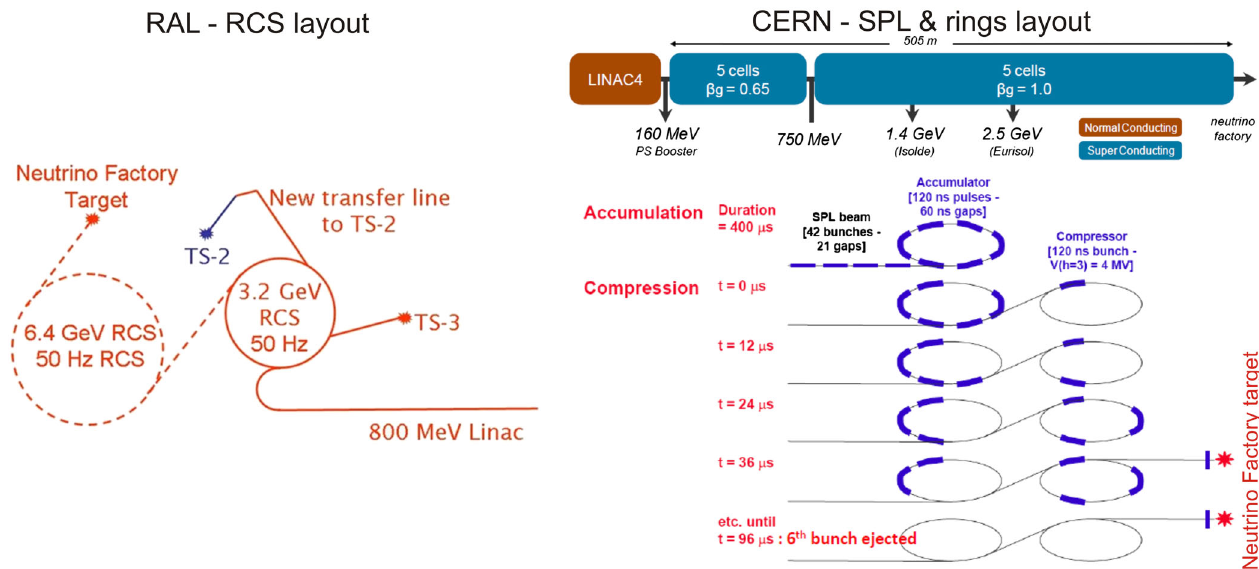
FIG. 3. The proposed 4 MW proton drivers for a neutrino factory fall in two categories. The RAL option (left panel) consists of a medium energy linac injecting into two rapid-cycling synchrotrons delivering beam to the spallation-neutron targets and the neutrino factory target [35]. The CERN option (right panel) consists of the SPL linac [39,40] followed by an accumulator and compressor ring